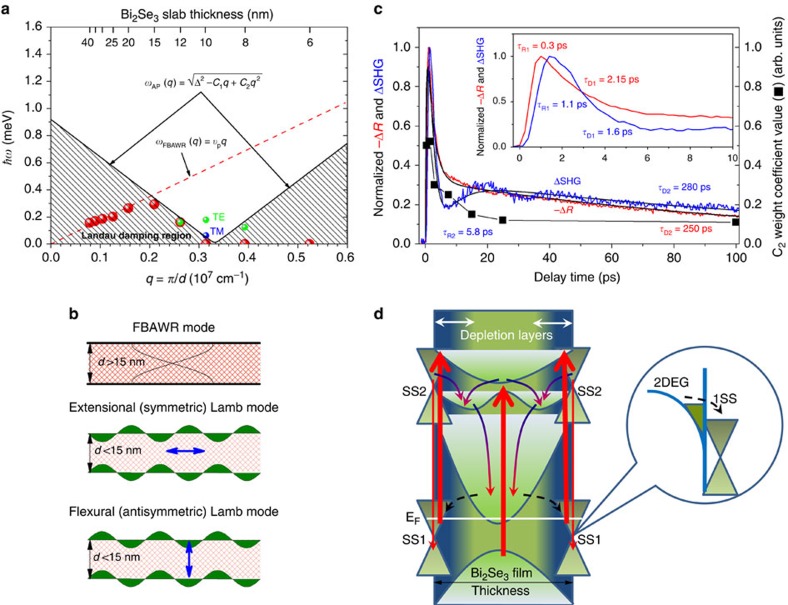
CADP modes and the unique conditions for their excitation in thin-films of Bi2Se3.(a) Dispersion of the FBAWR modes observed in ref. 55 for the same Bi2Se3 films of different thicknesses (red dots) and the excited TE and TM guided CADP modes (green and blue dots, respectively) are shown. Red dashed line approximates the linear dispersion of FBAWR modes, whereas solid black line shows the dispersion of AP in the presence of fermion tunnelling between the opposite-surface Dirac SS, which was modelled using equation (4) with Δ=0.92 meV, C1=5.1, and C2=7.684. Patterned area represents the Landau damping regions. (b) A schematic representation of the FBAWR modes for films with d>15 nm and the extensional (symmetric) and flexural (antisymmetric) Lamb modes for films with d<15 nm. Blue arrows indicate the direction of the evanescent guided Lamb wave oscillations. (c) The normalized TSHG and negative TR traces for the 10 nm thick film are shown together with the fit curves (black solid lines). To guide the general tendency, the fit to the TSHG trace is shown without the oscillatory part. Inset shows zoom in on the same traces. The rise- and decay-time constants are shown in the corresponding colours. Black squares represent the temporal dynamics of the threefold symmetry component of the TSHGRA patterns (weight coefficient c2 in equation (2)). (d) Schematic sketch of the electronic structure of Bi2Se3 films and the relaxation dynamics in Dirac SS due to their direct optical coupling to ∼1.51 eV incident photons (thicker red arrows). Thinner-red and multicolour arrows present the recombination and LO-phonon-assisted relaxation processes, respectively. Black dashed arrows indicate 2DEG-to-Dirac1SS scattering which balances the corresponding electron densities and completely eliminates the depletion electric field , thus leading to the dominant contribution of purely surface sixfold rotational symmetry component originating from the topmost Se atomic layer of the film.